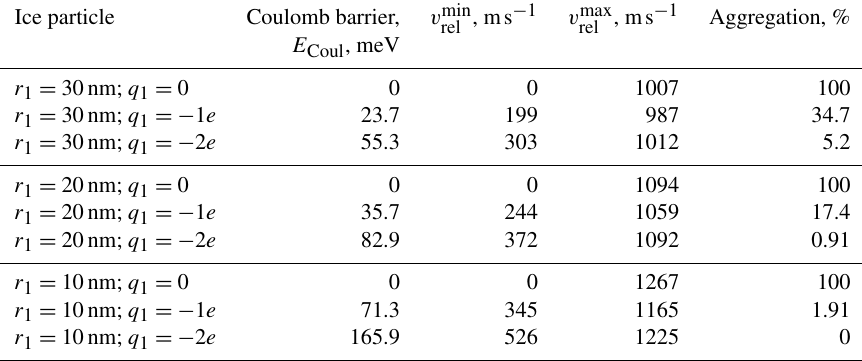
Table A1. Energetic considerations and the percentage of aggregation for FeO–ice collisions at T = 150K and k r = 0 . 9 (the surface point charge model). The FeO particle has the fixed radius and charge ( r 2 = 0 . 2nm, q 2 = − 1 e ), and the size and charge of the ice particle is varied. The collision geometry is shown in Fig. 3a.